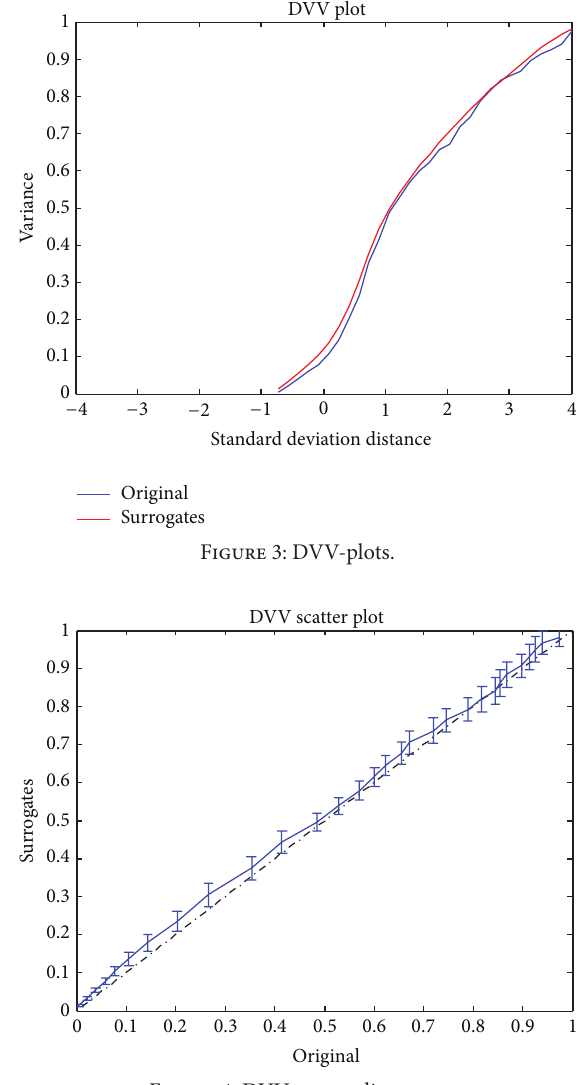
Table 1: The error statistics of the ELM model for the three compo-